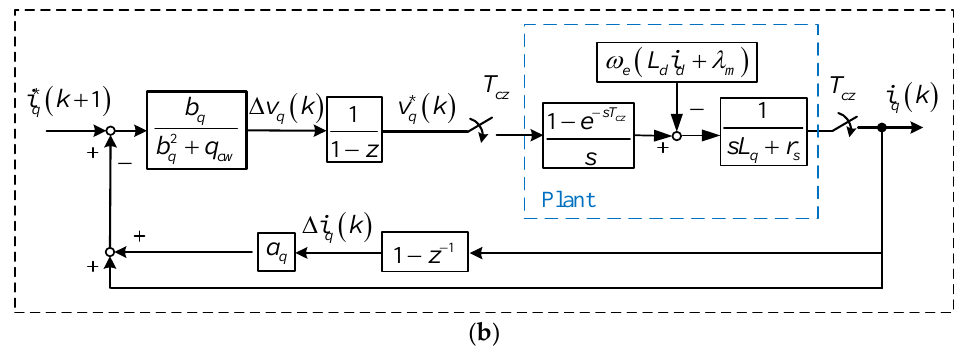
Figure 8. Block diagram of the predictive current control. ( a ) d -axis current control, ( b ) q -axis current control.